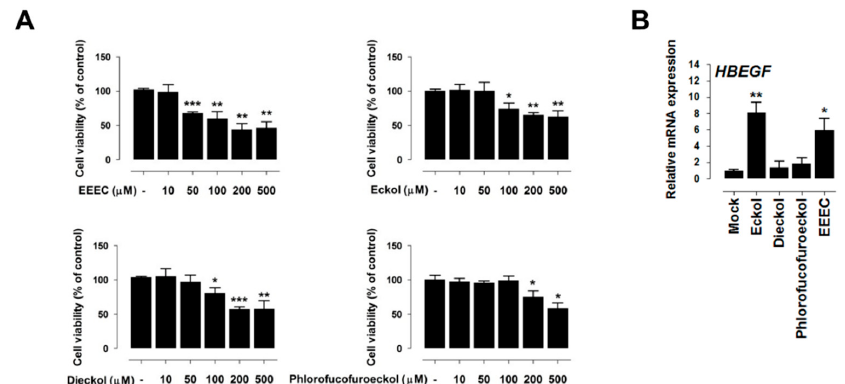
Figure 2. Toxicity of ethanol extracted of dried E. cava (EEEC), eckol, dieckol, and phlorofucofuroeckol ( A ) EEEC, eckol, dieckol, and phlorofucofuroeckol toxicity was evaluated by performing a cell viability assay using IPEC-J2 cells incubated with the indicated concentrations of each compound for 24 h. ( B ) Heparin-binding epidermal growth factor-like growth factor ( HBEGF) expression in the treatment groups (EEEC, eckol, dieckol, and phlorofucofuroeckol). In qRT-PCR analysis, target gene expression levels were normalized to those of glyceraldehyde 3-phosphate dehydrogenase ( GAPDH ). Error bars indicate standard error of triplicate analyses. * p < 0.05, ** p < 0.01, *** p < 0.001. Indeed, eckol incubation with different concentrations (10 µM, 20 µM, 50 µM, 100 µM, and 200 µM) for 24 h resulted in a concentration-dependent increase in PDX1 (Figure 3A,B) and HBEGF (Figure 3C,D) mRNA and protein levels.